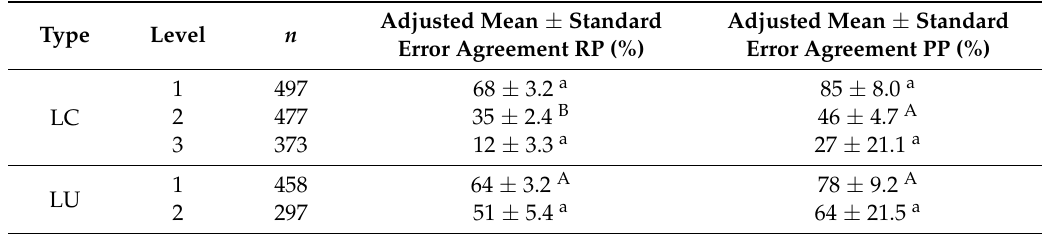
Table 11. Models tested to compare power player (PP) evaluations and regular players (RP) with regards to the agreement (yes/no) in land cover (LC) and land use (LU) between FotoQuest Austria and LUCAS 2015. Number of observations ( n ) is